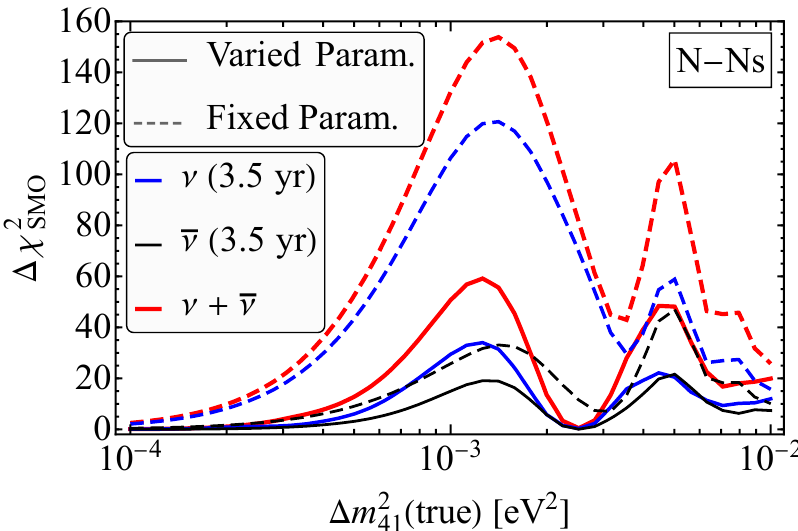
on ∆ m 2 , for the N-Ns ( ∆ m 2 > 0 , ∆ m 2 > 0 ) scenario. The 41 31 41 SMO